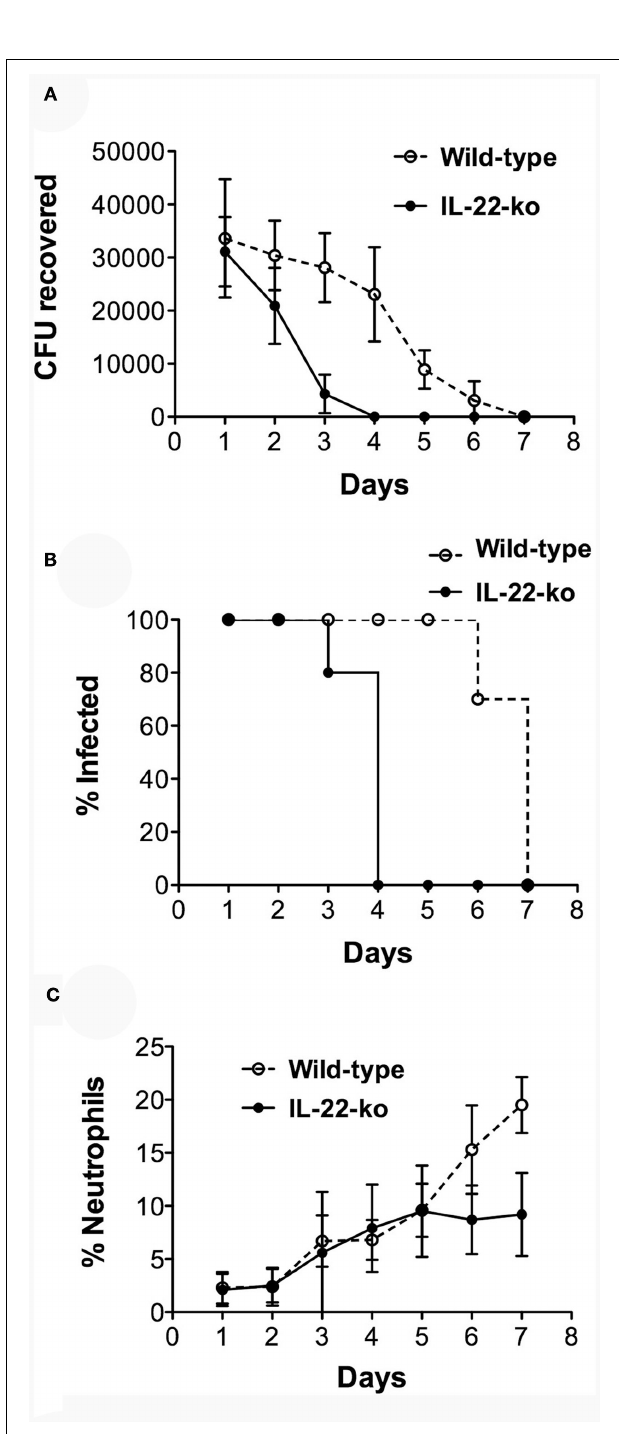
FIGURE 3 | Shortened duration of vaginal gonococcal infection in IL-22-ko mice. IL-22-ko orWT C57BL/6 mice (10 per group) were infected vaginally with N. gonorrhoeae on day 0; infection was monitored by vaginal swab culture, and the neutrophil influx was determined by microscopic examination of vaginal smears. (A) Number of recoverable N. gonorrhoeae (mean ± SD, CFU/mouse); (B) , percentage of mice remaining infected each day ( P < 0.001; Kaplan–Meier); (C) , neutrophils relative to epithelial cells (mean ± SD, %). Data shown from one of three experiments yielding similar